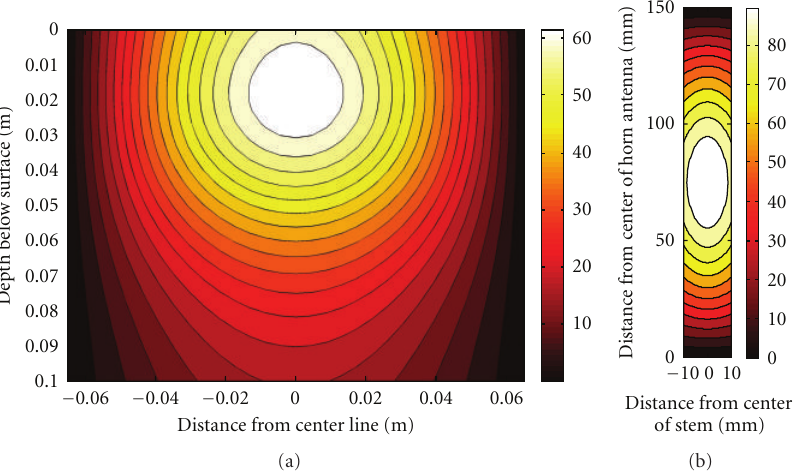
Figure 2: Typical temperature distribution created by a pyramidal horn with aperture dimensions of 130mm by 43mm and a length of 100mm in soil profile (a) and the cross section of a 10mm thick plant stem (b) calculated using equations presented in [20]. (Note: the temperature scales are in ◦ C).